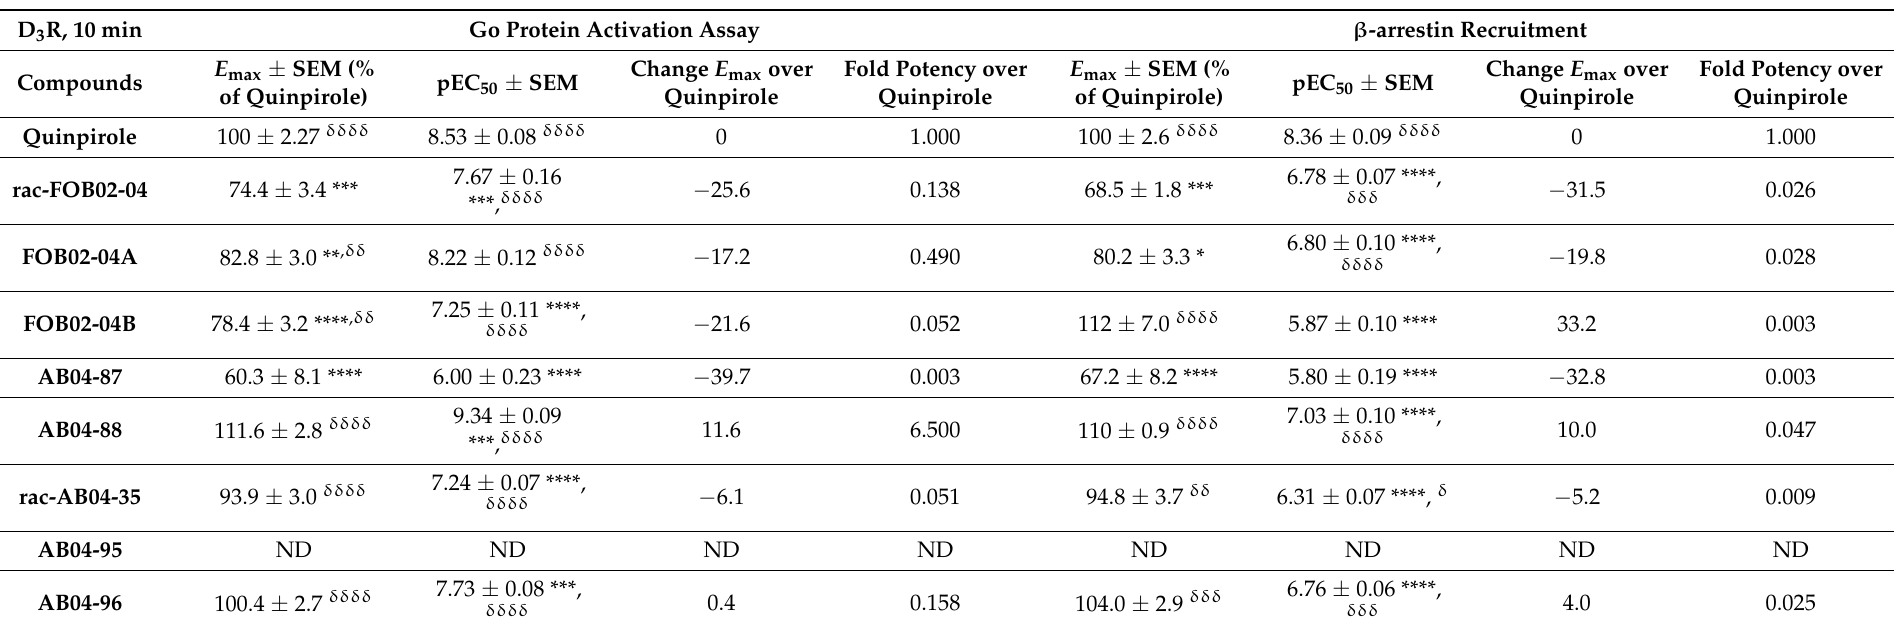
Table 1. Pharmacological comparison of bitopic ligands at